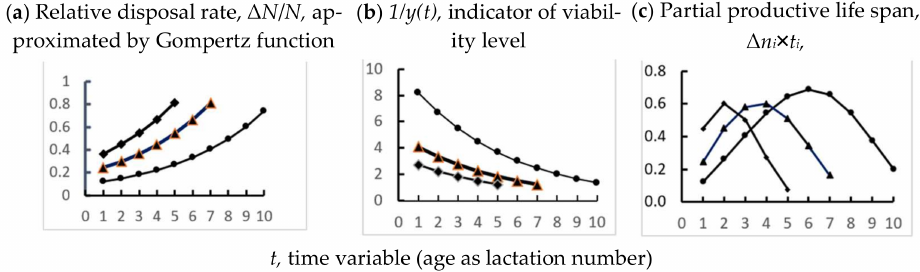
Figure 4. Age dynamics of three indicators of herd turnover for 3 model cohorts. y ( t ) is Gompertz function as relative culling ( ∆ Ni / Ni ); 1/y(t) is indicator of viability of cows; ∆ n i = ∆ N i /N 1, t i — lactation number, ∆ n i × t i —p artial productive life span, i.e., relative number of cows in herd with productive life span equal to given lactation number. The average productive life span T = Σ ∆ n i × t i . For all 3 variants: c = 0.2; • B = 0.1; (cid:78) B = 0.2; (cid:7) B =